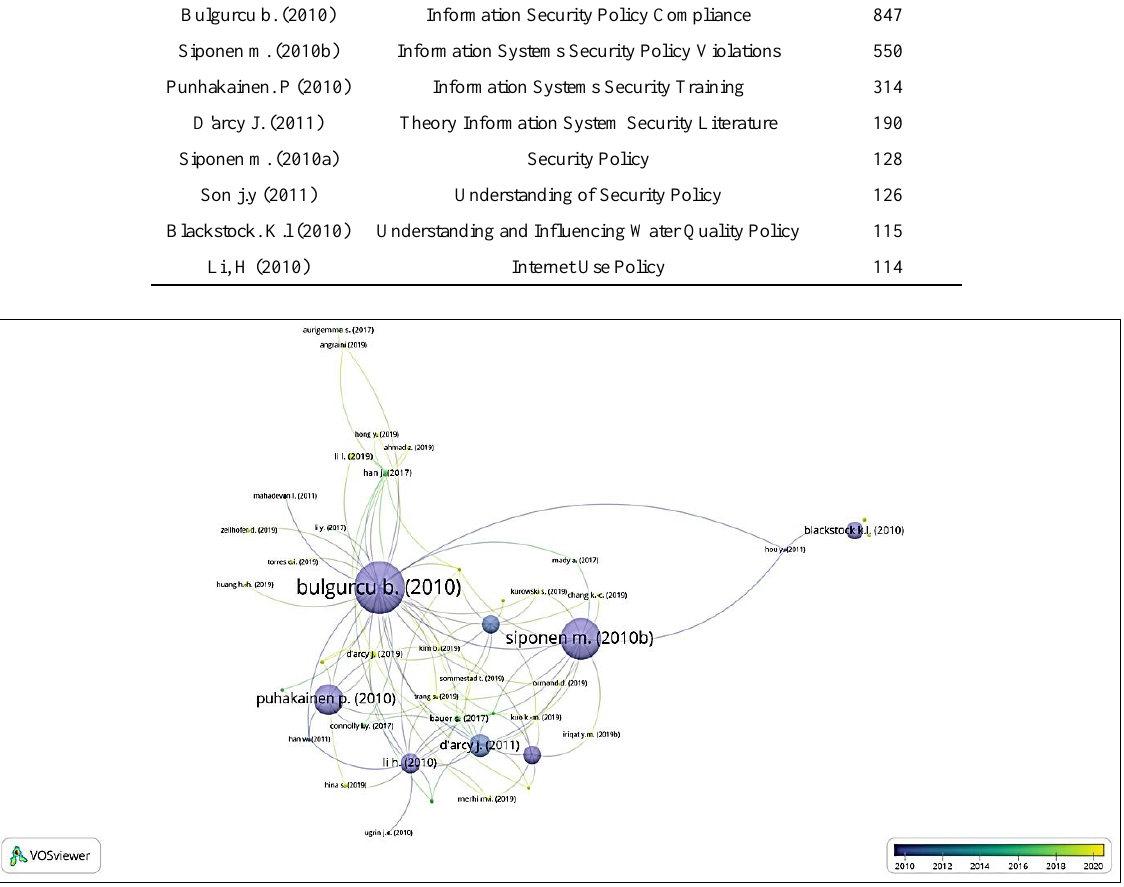
Figure 5. Citation network of theory related policy publications. Note: The figure shows how commonly publications (with at least ADD citations) get cited by others in the network. Nodes denote their linkages and publications and convey citation relationships. Larger nodes show publications with more citations. Publications with close citation relationships are clustered together in nodes of the same color.